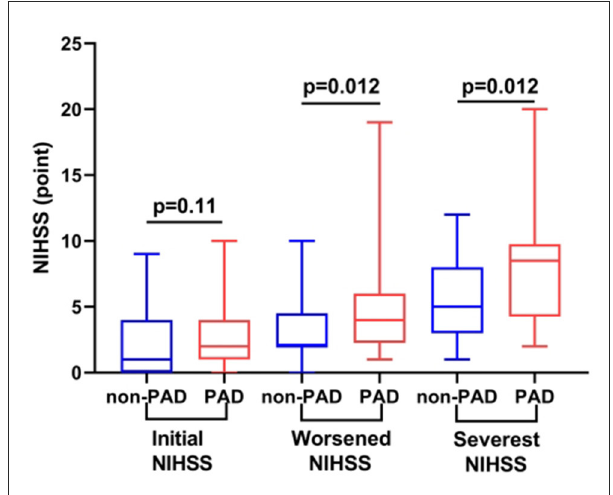
FIGURE4 Comparison of the NIHSS profiles of participants with and without PAD. Compared with participants without PAD, those with PAD had comparable initial NIHSS scores but higher/worsened and higher/more severe NIHSS scores (both p = 0.012). NIHSS, National Institutes of Health Stroke Scale; PAD, parental arterial